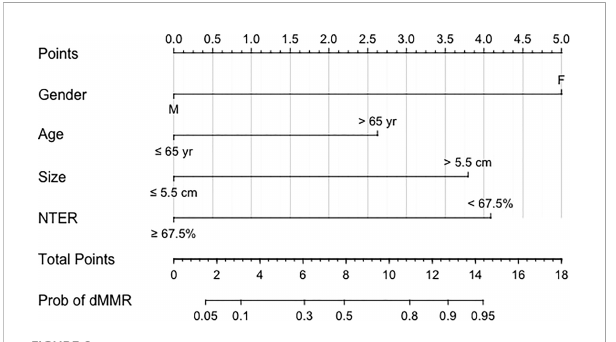
FIGURE 3 Receiver operating characteristic curves of the nomogram. AUC: area under the curve.